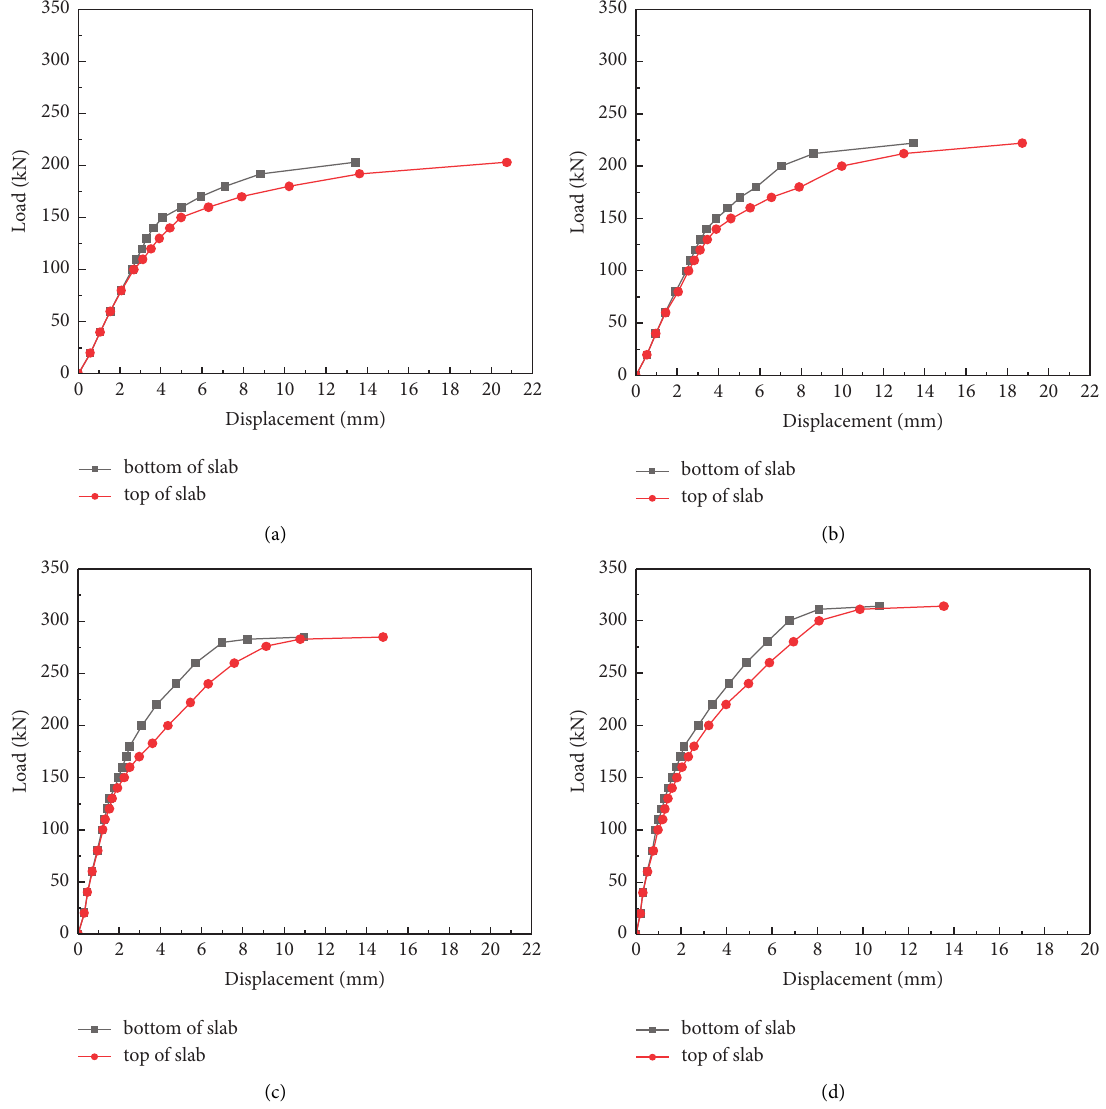
Figure 9: Load-deflection curves in the top and bottom of Slab 1-Slab 4: (a) Slab 1; (b) Slab 2; (c) Slab 3; (d) Slab